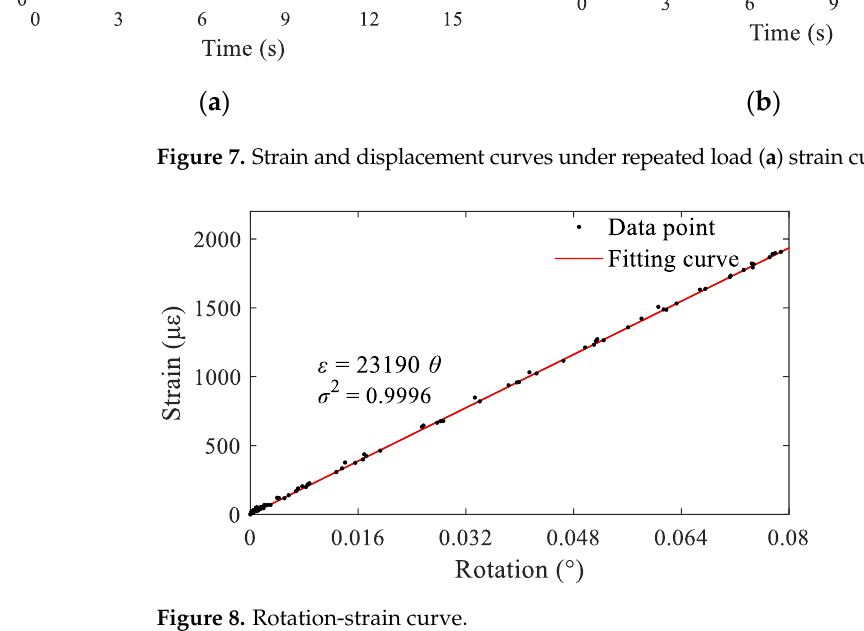
Figure 8. Rotation-strain curve.